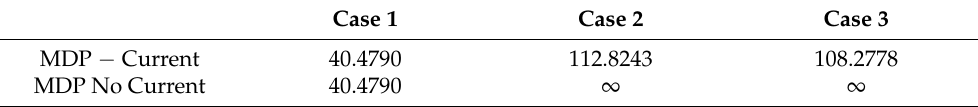
Table 5. The comparison of the travel time (h) along the optimal paths between with (MDP − Current) and without (MDP without Current) consideration of ocean currents. In this case, the AUV moves against the ocean current. ∞ means that the AUV cannot finish the predicted path due to strong counter-currents.